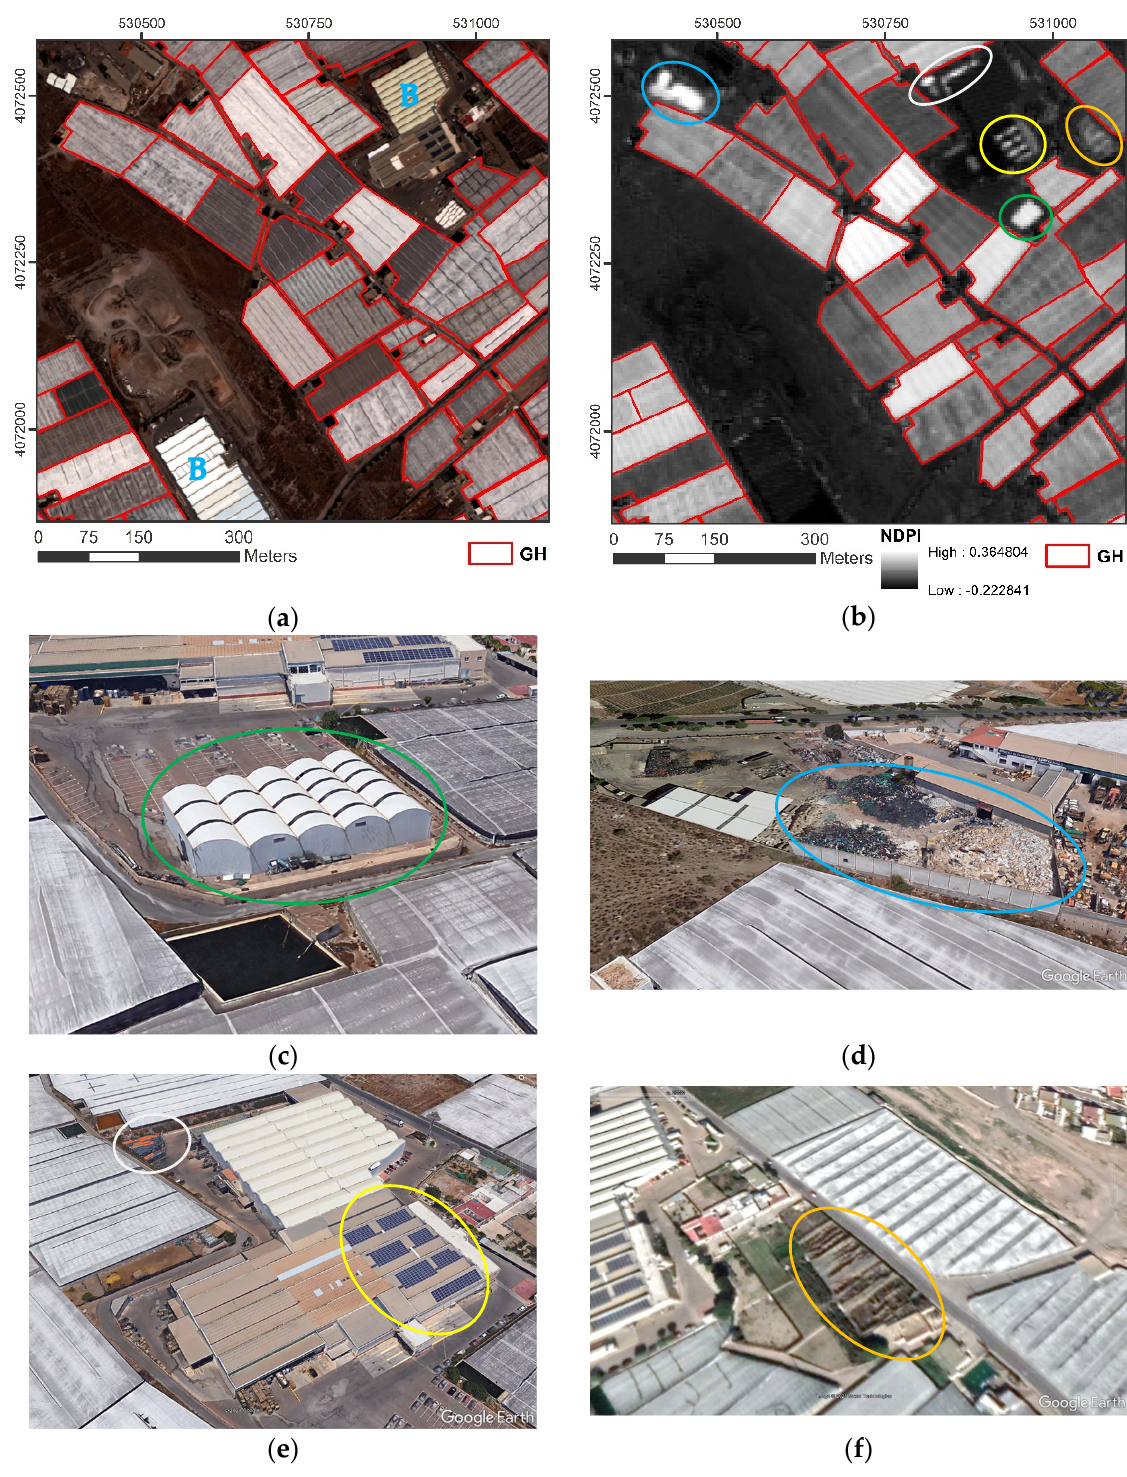
Figure 5. NDPI index performance: ( a ) RGB WV3 orthoimage with GH polygons in red (the letters B in blue indicate agricultural buildings); ( b ) NDPI index and ellipses point out plastic areas belonging to Non-GH class; ( c ) green ellipse showing a plastic farm building; ( d ) blue ellipse depicting a plastics recycling plant; ( e ) white and yellow ellipses illustrate piles of plastic crates and plastic solar panels, respectively; ( f ) orange ellipse showing an abandoned greenhouse. All the detailed images come from Google Earth.